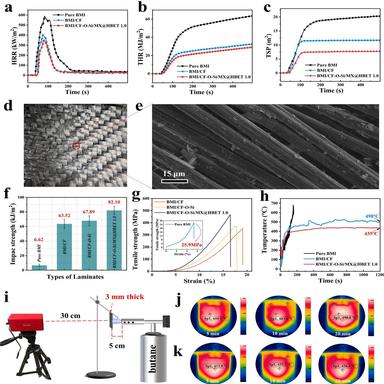
(a) HRR, (b) THR, and (c)TSP curve of pure BMI and CFRP; (d) Impact and (e) stretch test of pure BMI and its laminates with CF. (f) Digital and (g) SEM pictures of BMI/CF-O-Si/MX@HBET 1.0 after combustion; (h) Backplane maximum temperature profile of pure BMI, BMI/CF and BMI/CF-O-Si/MX@HBET; (i) Layout diagram of backplane temperature test device; Thermal image of 3 mm thick with back temperature distribution from 0 to 20 min (j) BMI/CF and (k) BMI/CF-O-Si/MX@HBET 1.0.